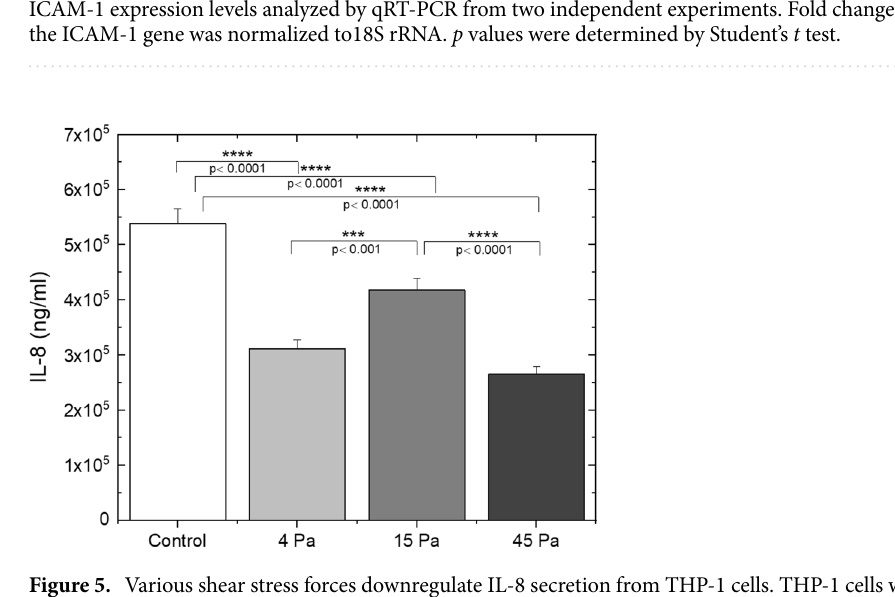
Figure 4. 15 Pa of shear stress leads to an increase in ICAM-1 relative expression in THP-1 cells. THP-1 cells were either kept in a static environment (control) or treated with 15 Pa for 3 h (15 Pa). Bar graph indicates mean